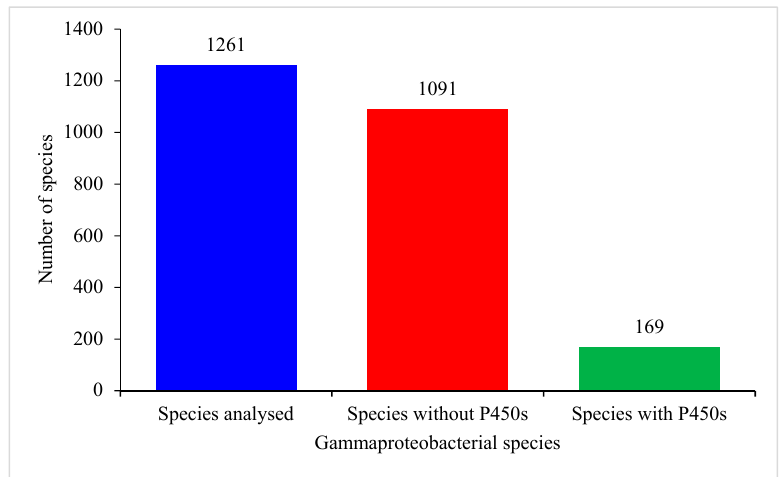
Figure 1. Analysis of P450s in Gammaproteobacterial species. Detailed analysis of the species and P450s is presented in Supplementary Dataset 1.